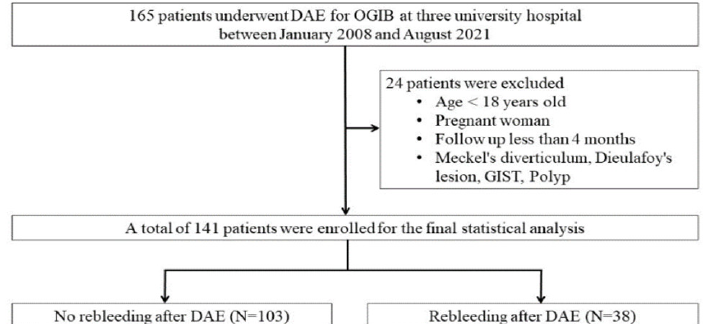
Figure 1. Flow chart of selecting the study population. Among 165 patients that underwent DAE for OGIB, 24 were excluded according to the exclusion criteria. Finally, 141 patients from three Korean institutes were selected for the statistical analysis.